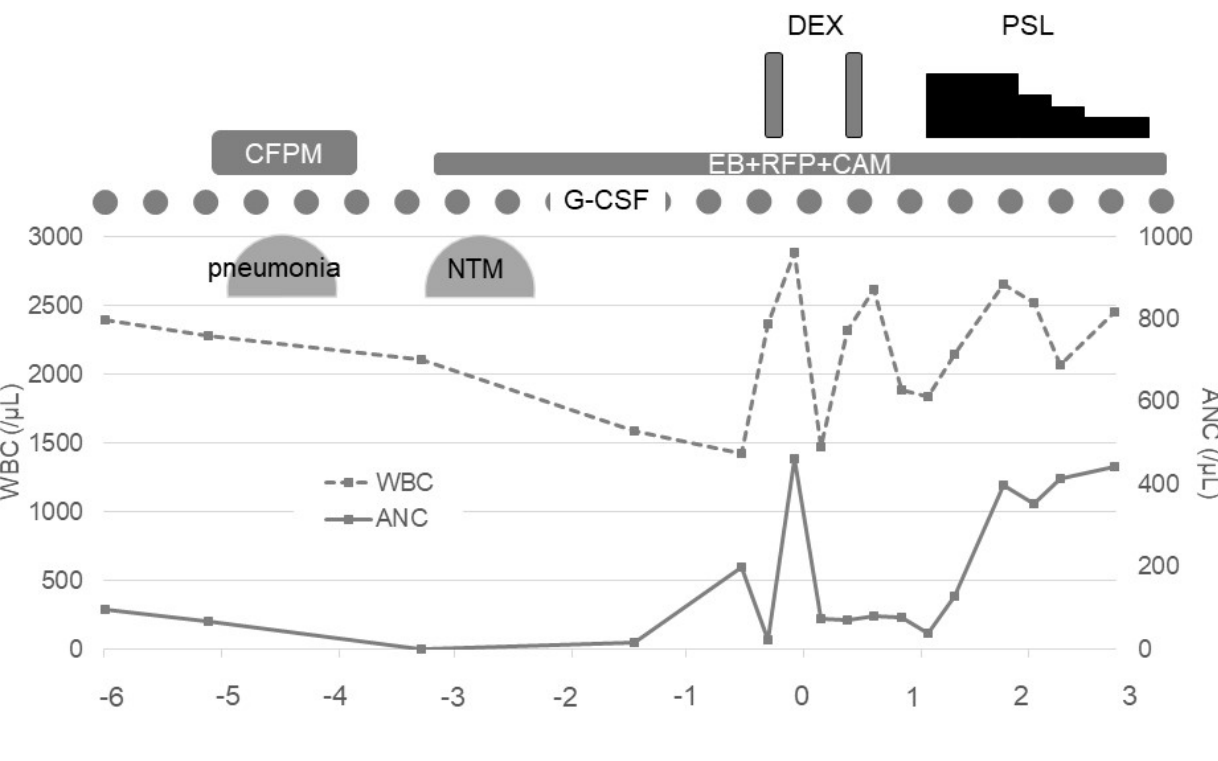
Figure 1. A bone marrow aspiration before corticosteroid therapy. Segmented cells phagocytosed and destroyed by macrophages (white arrows) were observed.